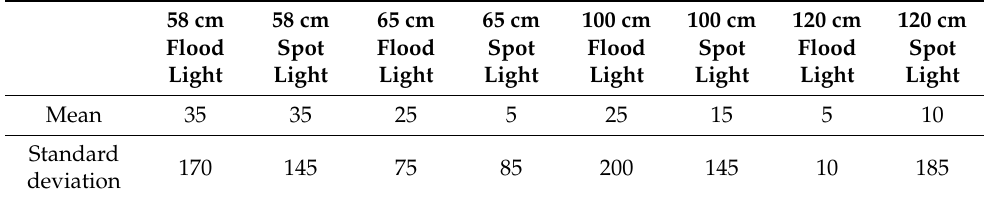
Table 3. Relative errors (%) of the mean and standard deviation estimates.